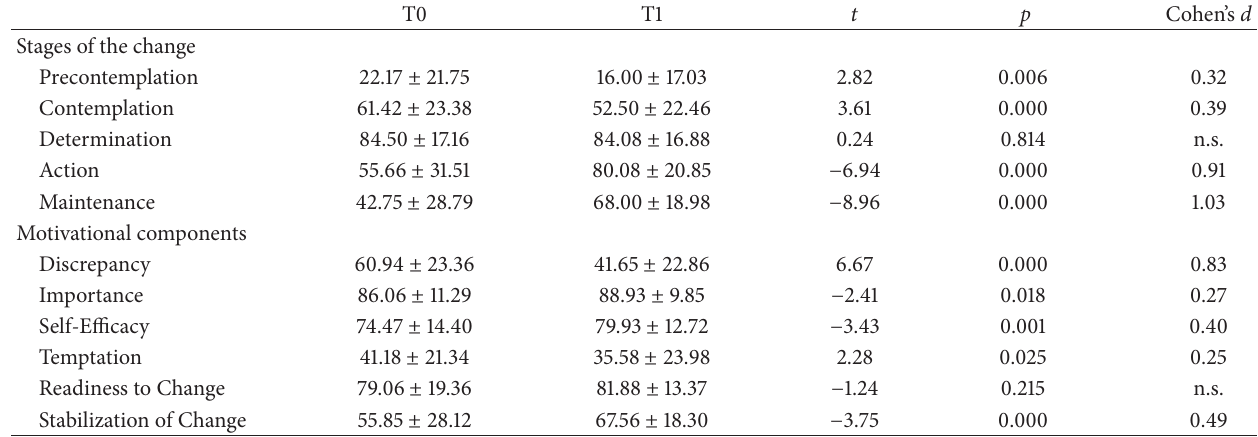
Table 2: Motivation to change to physical activity (PA) at baseline and after the intervention. Data are presented as mean ± SD. T0 T1 𝑡 p Cohen’s